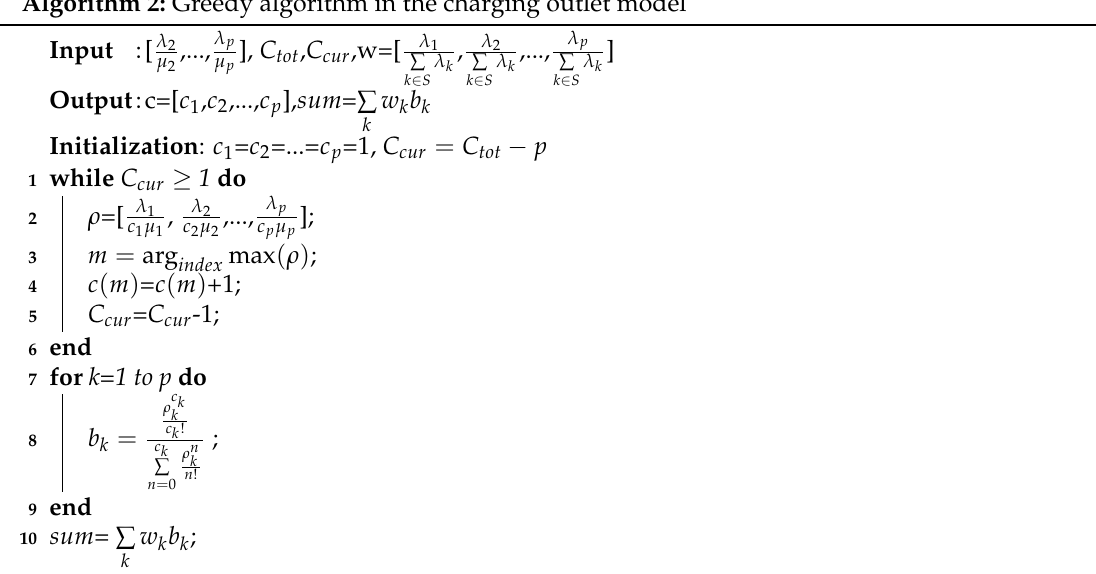
Algorithm 2: Greedy algorithm in the charging outlet